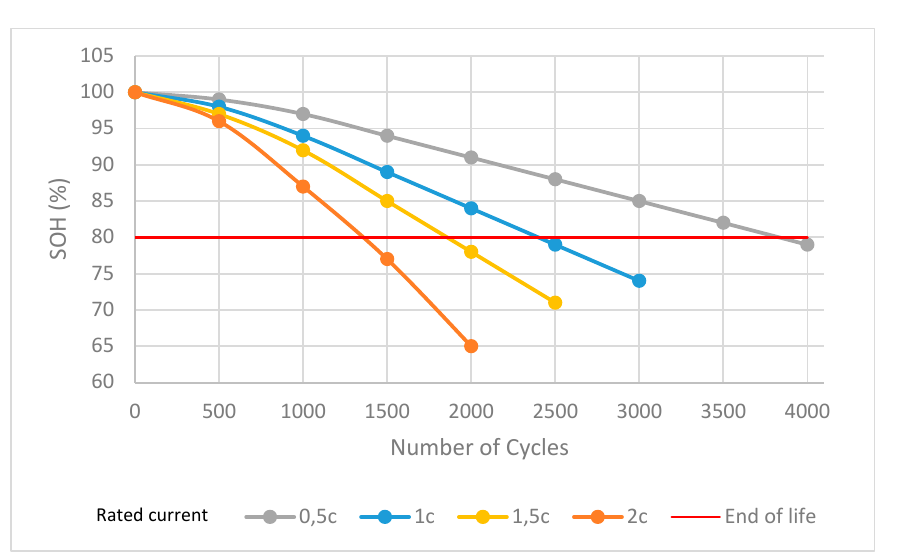
Figure 4. Battery lifetime data at various rated current.